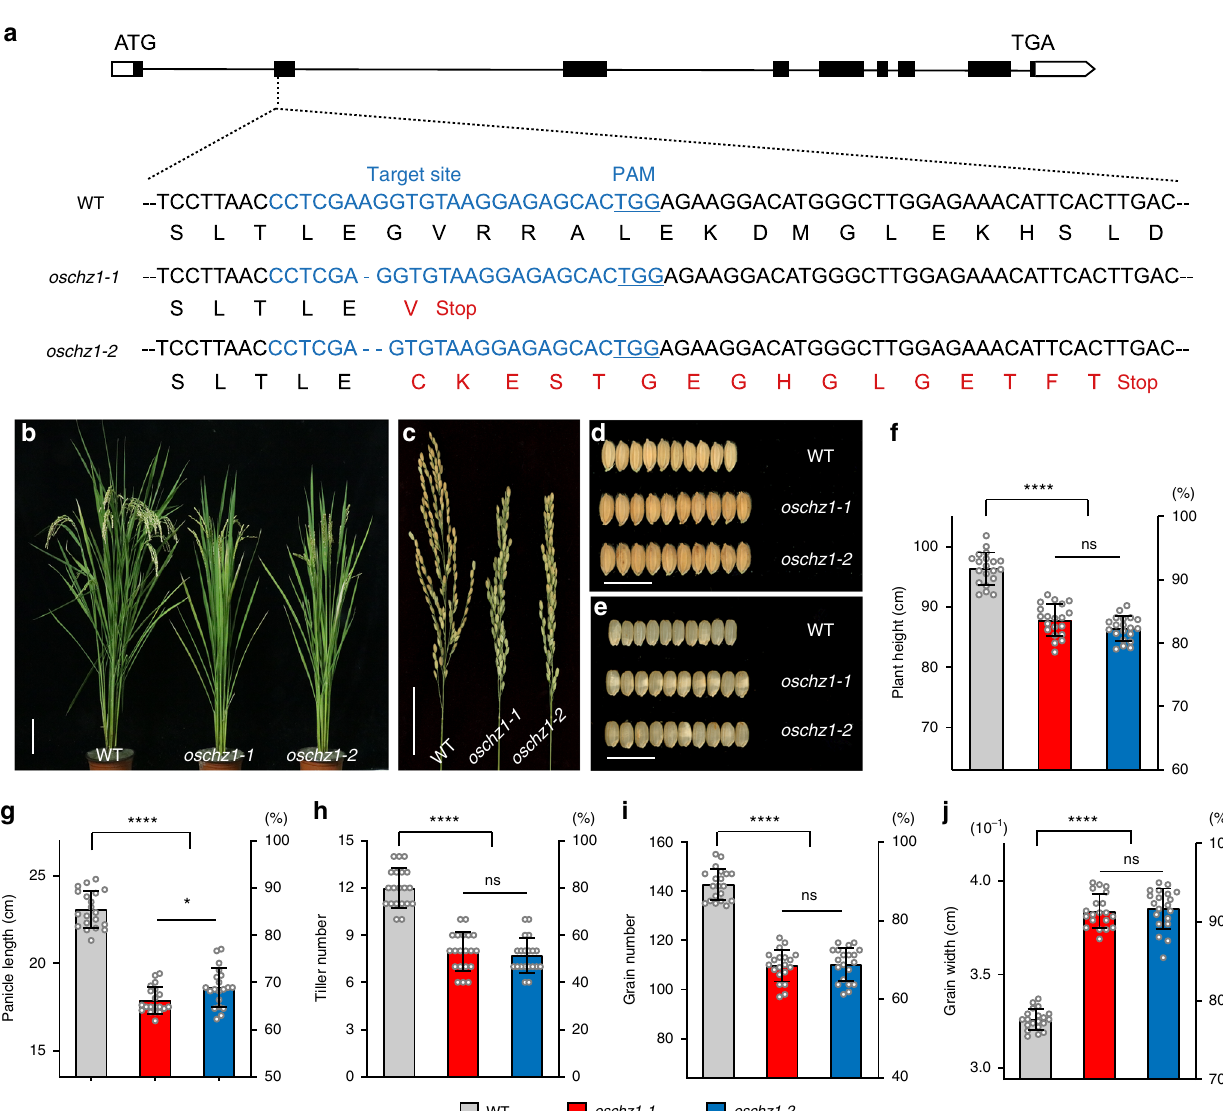
Fig. 4 Characterization of OsChz1 function via CRISPR/Cas9-induced mutagenesis. a Schematic diagram of the OsChz1 gene structure and the mutants generated through CRISPR/Cas9 target. UTRs, exons, and introns are indicated by blank rectangles, black rectangles, and black lines, respectively. The sequence of the targeted site with the underlined protospacer adjacent motif (PAM) and altered amino acid sequence in the oschz1-1 and oschz1-2 mutants are highlighted in blue and red, respectively. b Representative 95-day-old plants of mutants compared to wild-type (WT) grown under long-day (LD) photoperiod conditions. Scale bar, 10 cm. c Comparison of the main panicle morphology between WT and the oschz1 mutants. Scale bar, 5 cm. d Comparison of mature grains between WT and the oschz1 mutants. Scale bar, 1 cm. e Comparison of brown rice grain between WT and the oschz1 mutants. Scale bar, 1 cm. f – j Quantitative analysis of agronomic traits for plant height ( f ), panicle length ( g ), tiller number ( h ), grain numbers ( i ), and grain width ( j ), respectively. Values are shown as means± standard deviation from n = 20 individual plants. Statistic signi fi cances were determined by two- tailed, paired Student ’ s t -test: * p < 0.05; **** p < 0.001; ns (not signi fi cant), p > 0.05. The exact p values are 1.88 × 10 − 12 (WT vs. oschz1-1 ), 6.67 × 10 − 16 (WT vs. oschz1-2 ), 0.0699 ( oschz1-1 vs. oschz1-2 ) for f ; 4.08 × 10 − 20 (WT vs. oschz1-1 ), 1.41 × 10 − 15 (WT vs. oschz1-2 ), 0.0204 ( oschz1-1 vs. oschz1-2 ) for g ; 1.56 × 10 − 12 (WT vs. oschz1-1 ), 8.22 × 10 − 14 (WT vs. oschz1-2 ), 0.5079 ( oschz1-1 vs. oschz1-2 ) for h ; 1.12 × 10 − 18 (WT vs. oschz1-1 ), 5.48 × 10 − 18 (WT vs. oschz1-2 ), 0.8124 ( oschz1-1 vs. oschz1-2 ) for i ; 5.63 × 10 − 25 (WT vs. oschz1-1 ), 3.36 × 10 − 23 (WT vs. oschz1-2 ), 0.6914 ( oschz1-1 vs. oschz1-2 ) for j . Source data underlying f – j are provided as a Source Data fi were drastically reduced in oschz1-1 and oschz1-2 . Similarly, the photoperiod conditions were used in the analysis. As shown in expression of Early heading date 1 ( Ehd1 ), which encodes a B- Fig. 5d, OsChz1 exhibited a diurnal expression pattern in WT, type response regulator acting as an inducer upstream of Hd3a/ with a decrease by dawn and an increase by dusk during the RFT1 39 – 41 , was also reduced in the mutants. In contrast to Ehd1 , circadian rhythm. As expected, transcripts of OsChz1 were barely Hd3a , and RFT1 , the other examined genes showed roughly detected in the oschz1-1 and oschz1-2 mutants. Rice Flowering similar expression levels and patterns in the oschz1-1 and oschz1- Locus T1 ( RFT1 ) and Heading date 3a ( Hd3a ) are known as rice fl origen genes encoding small FT-like proteins to promote fl ow- 2 mutants as compared to WT (Fig. 5d). Based on these results, we conclude that OsChz1 promotes rice fl owering time through ering 37,38 . Interestingly, RFT1 and Hd3a transcription levels the Ehd1-Hd3a/RFT1 pathway. exhibited a strong diurnal rhythm in WT, whereas both of them